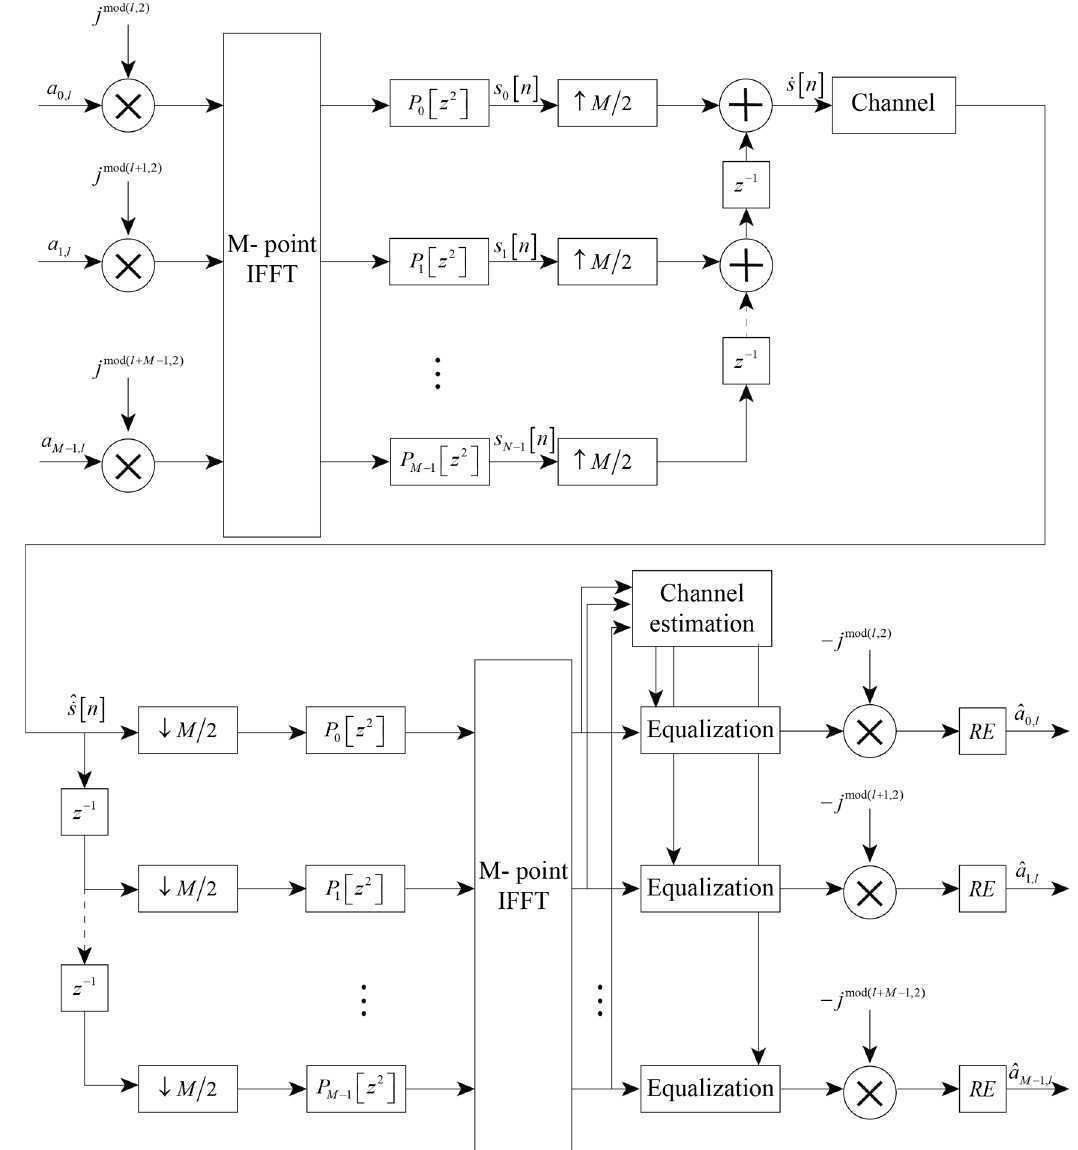
Figure 3. FBMC-OQAM data transmission model.